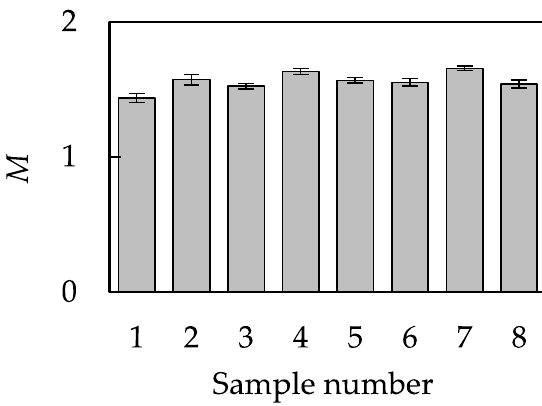
Figure 5. The relationship, M, between the tangential force F and load N (mean ± SD, n = 10).